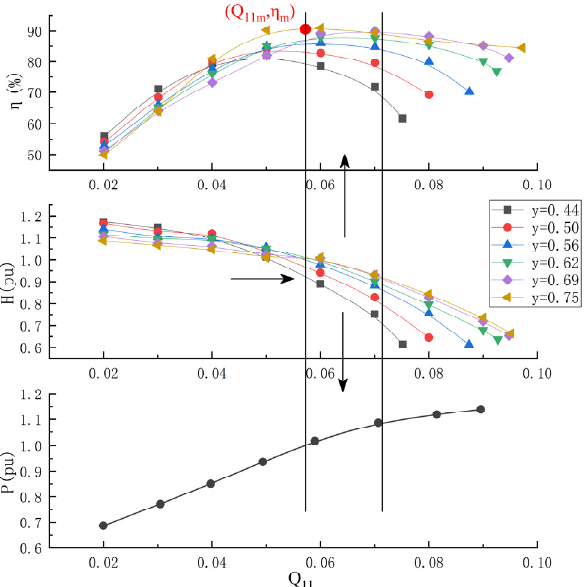
Figure 11. Characteristic curve of the model test in pump mode.